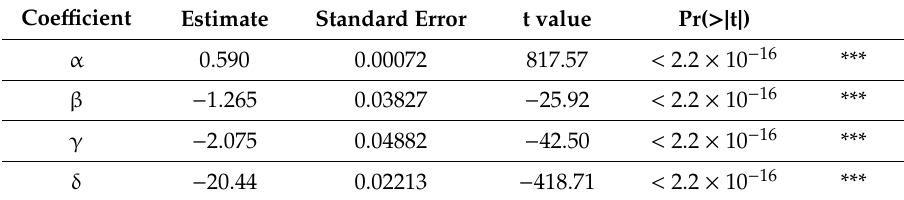
Table 3. Estimated coefficients for the third order polynomial function.